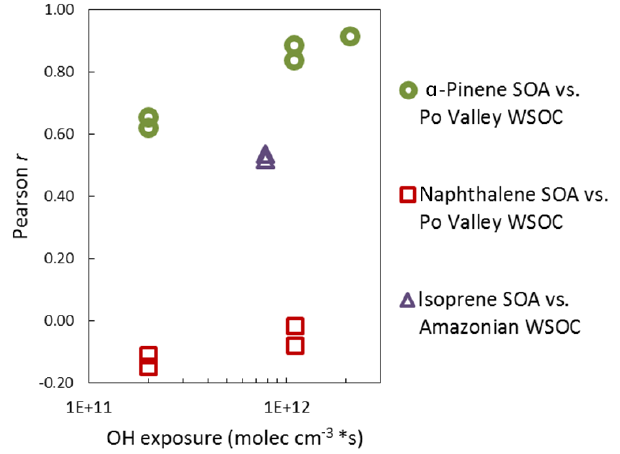
Figure 7. Pearson correlation coefficient between 1 H-NMR spectra of PAM-generated SOA and ambient PEGASOS